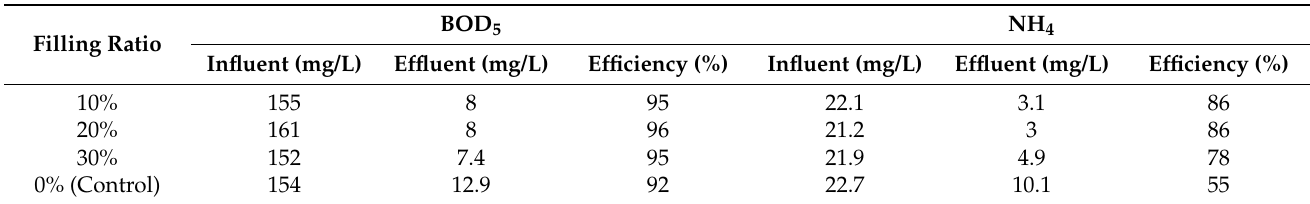
Table 2. Average values of treatment for PS-carrier.